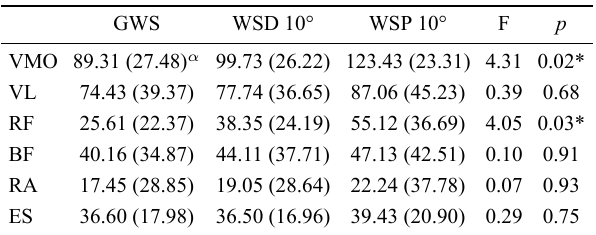
α Mean (standard daviation). VMO, vastus medialis obliques; VL, vastus lateralis; RF, rectus femoris; BF, biceps femoris; RA, rectus abdominis; ES, erector spinae; GWS, general wall squat; WSD 10°, wall squat with dorsiflexion 10°; WSP 10°, wall squat with plan- tarflexion 10°; * p <